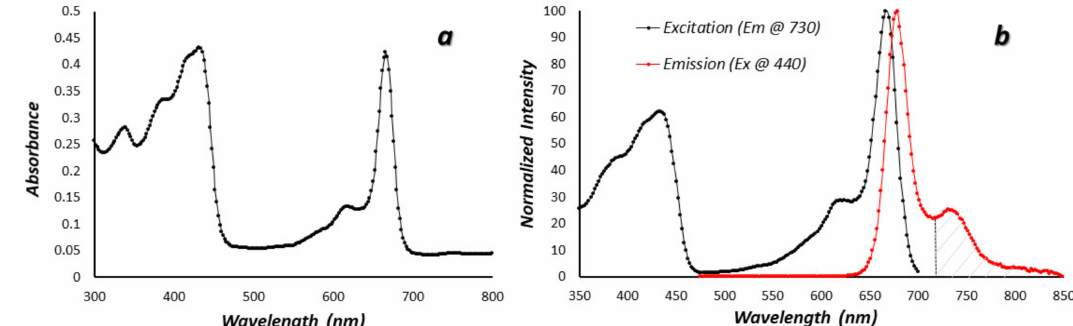
Figure 1. Chlorophyll a photophysical spectra in methanol solvent. ( a ) Simple absorbance spectrum in the near UV, visible, and NIR ( b ) Excitation (black) and emission (red) spectra of chlorophyll a, the main chlorophyll analog in corals. The cross-hatched region in the NIR above 720 nm shows the portion of the curve imaged in this